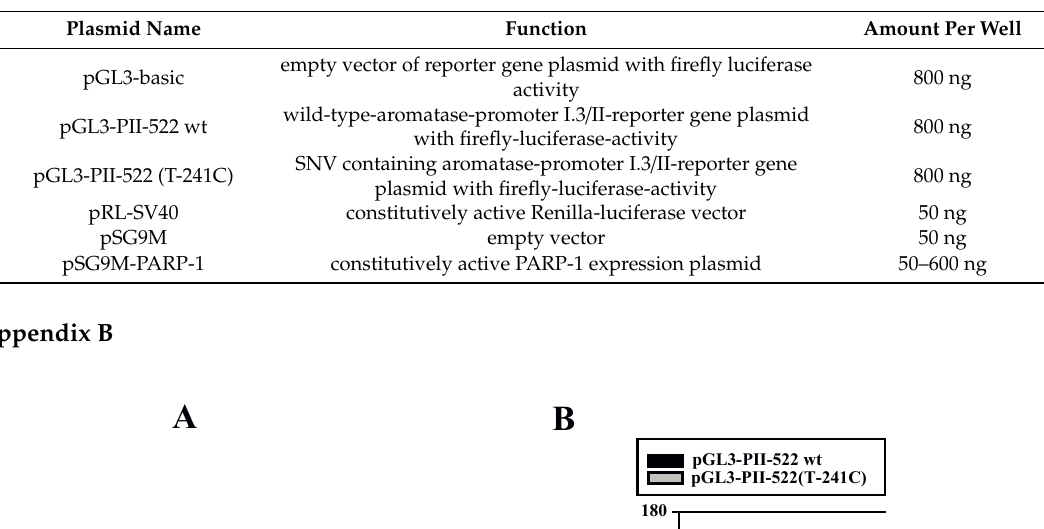
Table A3. Plasmids for transfection and reporter gene assays.